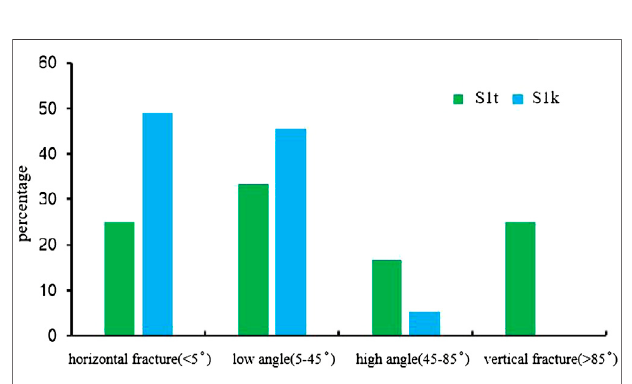
FIGURE 11 | Histogram of dip angle distribution of sandstone core fractures in Well Y in the Silurian of Shunbei area.